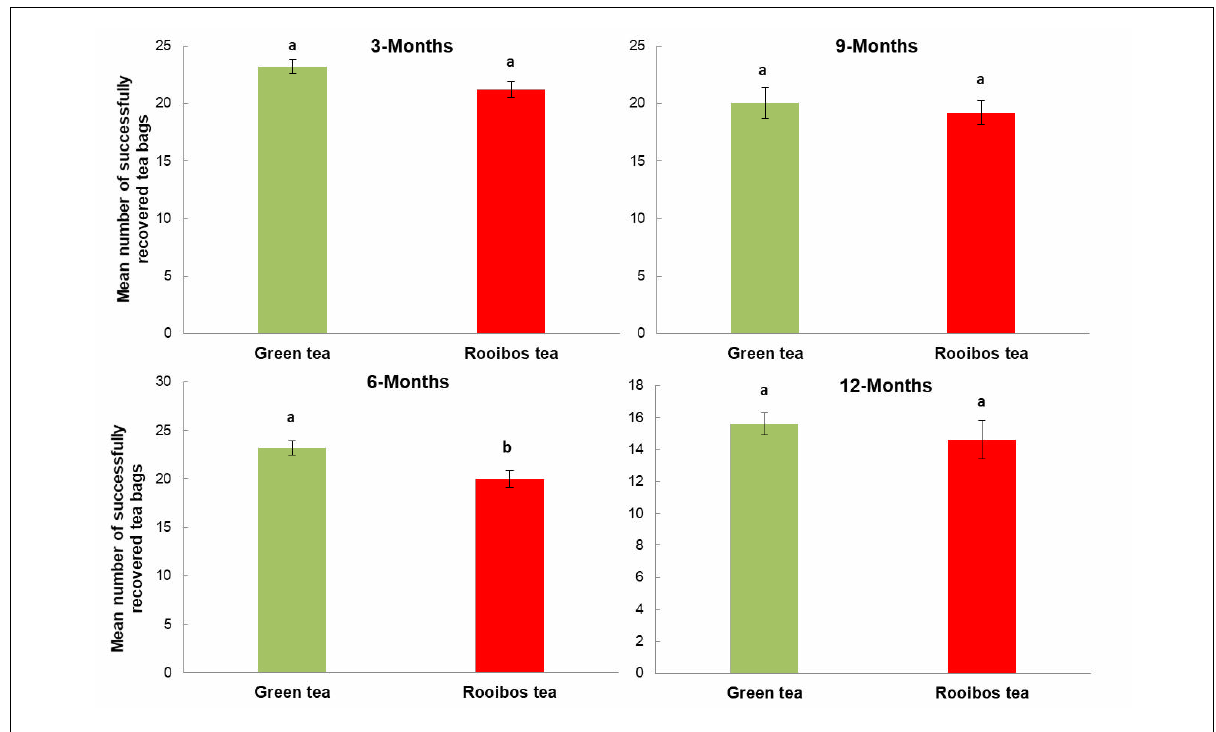
Figure 2: Mean number of successfully recovered tea bags over four incubation periods. Significant differences ( p <0.05) between tea bags are indicated with different lowercase letters.